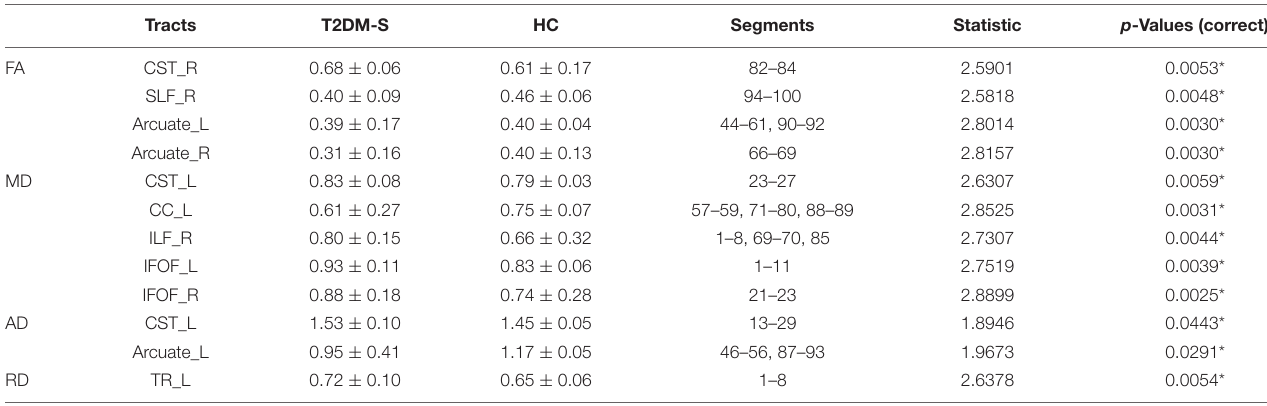
TABLE 3 | Diffusion measures statistics along the fiber